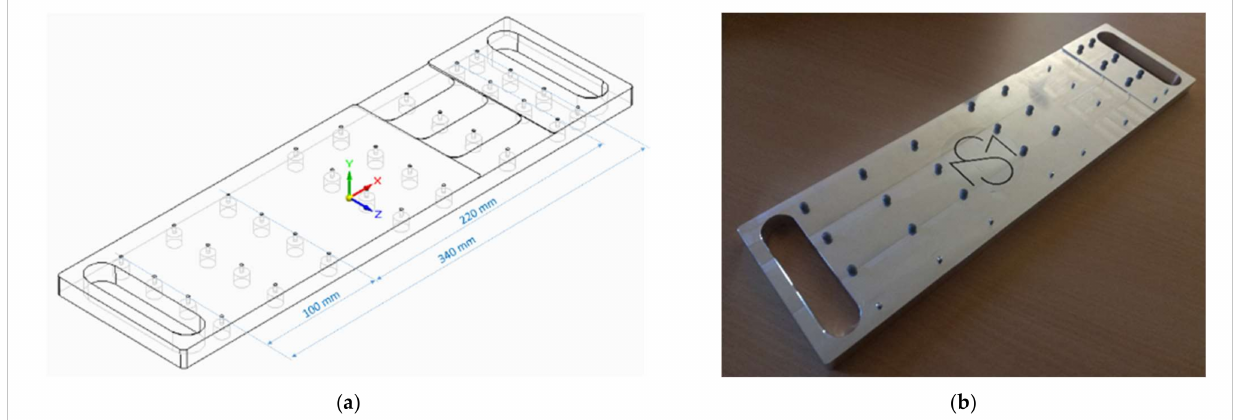
Figure 1. ( a ) Constructed calibration profile. ( b ) Manufactured calibration profile with M4 counter- sunk screws and infrared markers with a diameter of 6.5